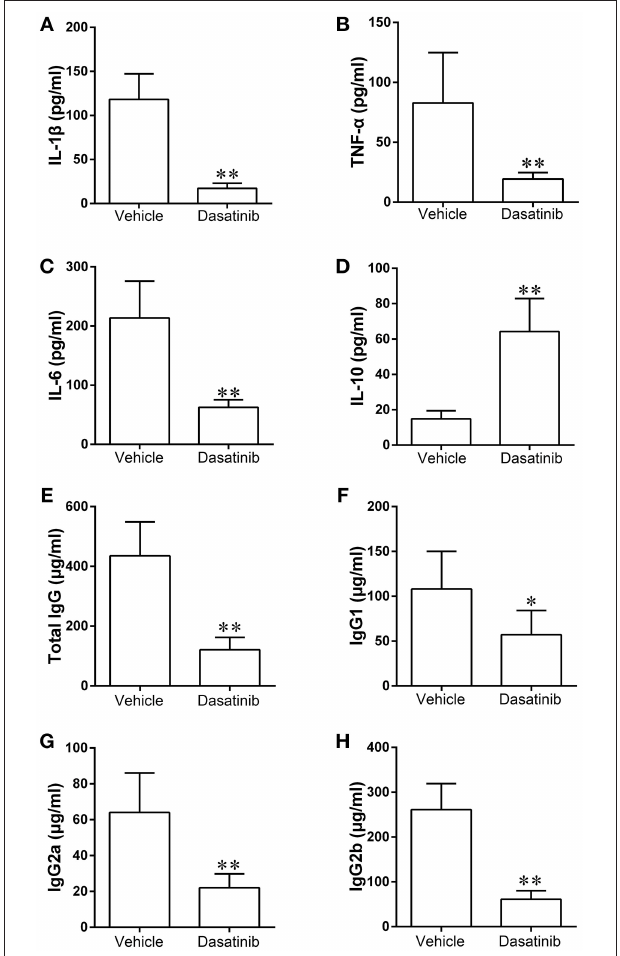
FIGURE 3 | Histopathological analyses were performed on hind ankle joints to evaluate the tissue structure alterations in CIA mice. (A) H&E stain, toluidine blue stain, safranin O stain and CD31 immunohistochemistry stain of ankle slices. (B) Histology scores of synovitis, inflammation, cartilage damage, bone erosion, and pannus formation in ankle joints. * P < 0.05, ** P < 0.01 vs. vehicle group ( n = 6 per group).